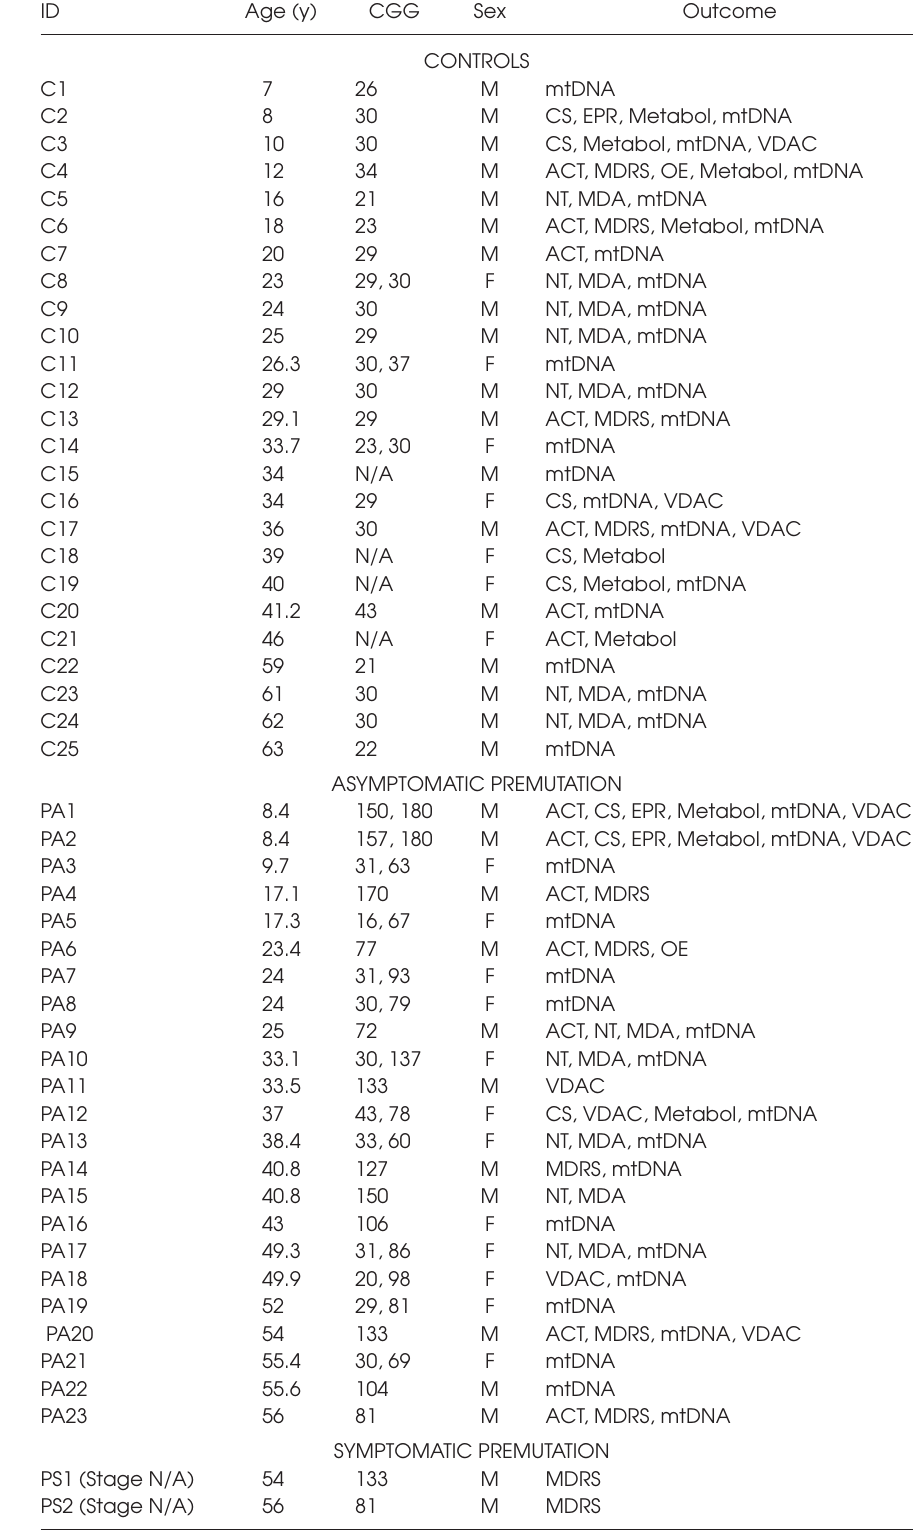
Table 1. Characteristics of the donors of fibroblasts utilized in this